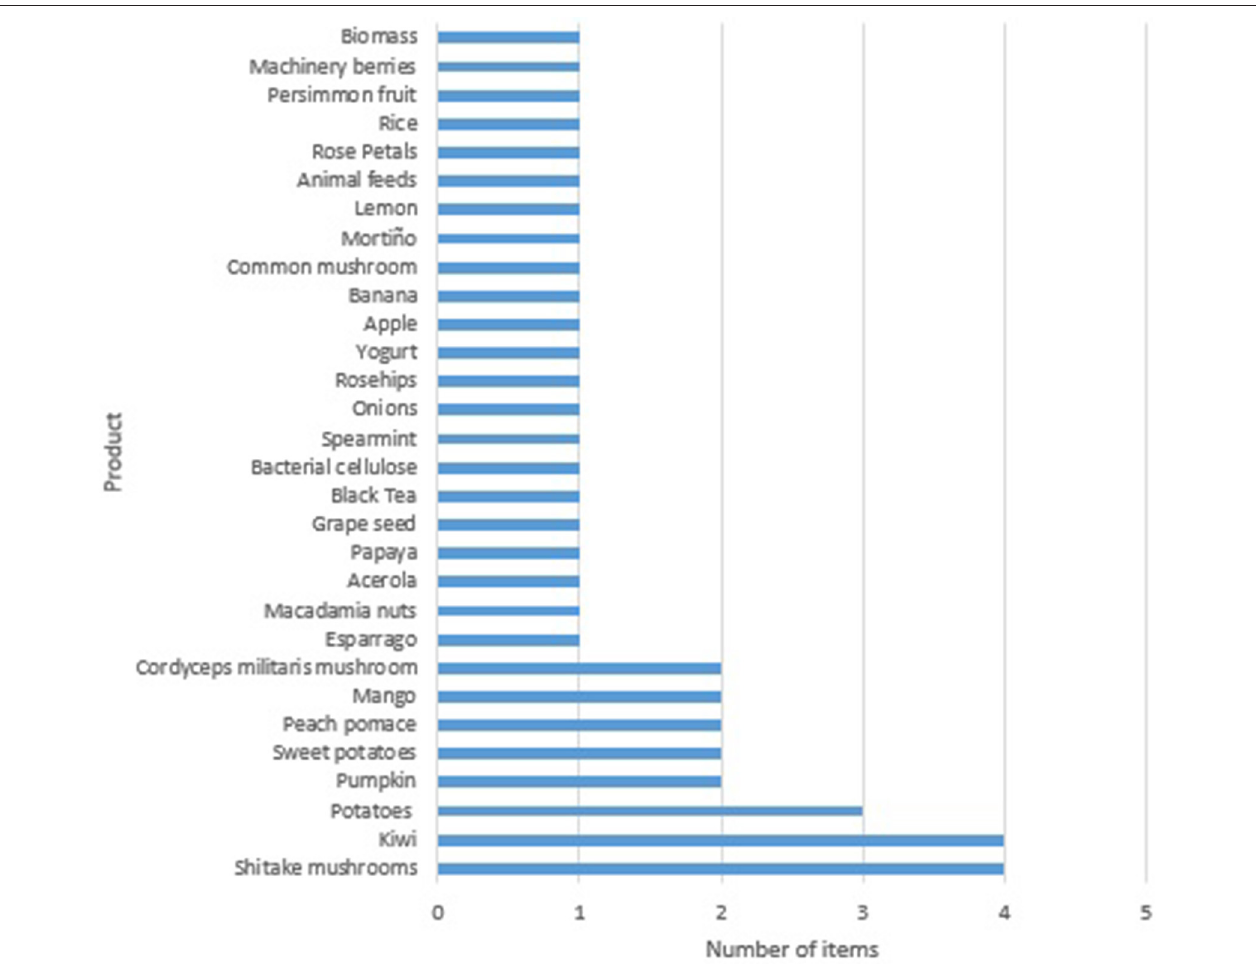
FIGURE 7 | Products or MPs investigated. Source: the